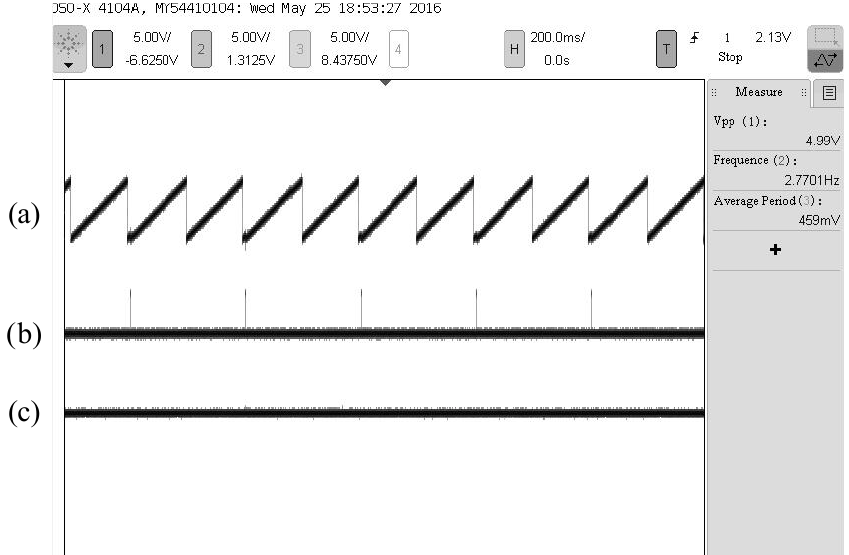
Figure 10. Oscillogram of the sensor output signal with a simulative rotational speed of 1000°/s: ( a ) Angular displacement information; ( b ) The refresh pulse; ( c ) Angular velocity information.